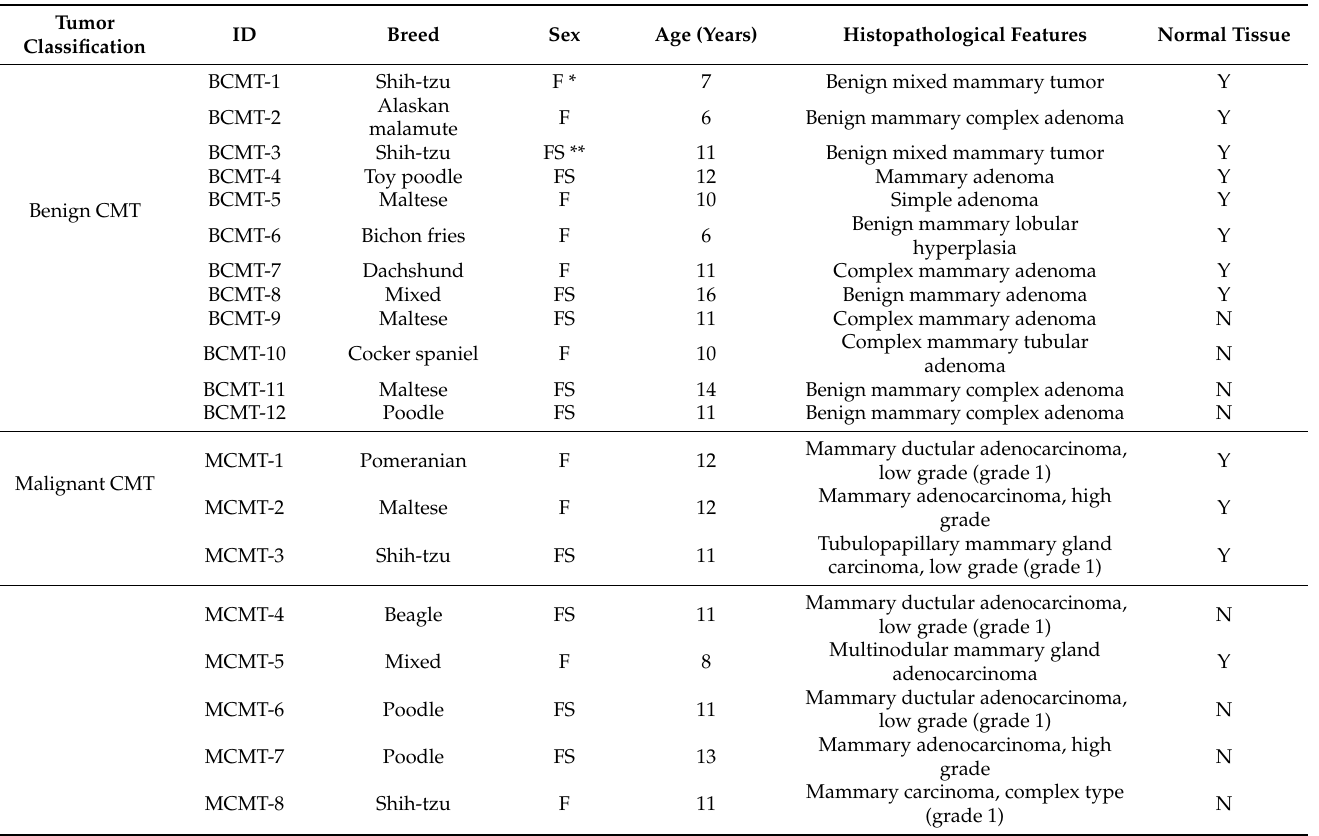
Table 3. Animals used for sample